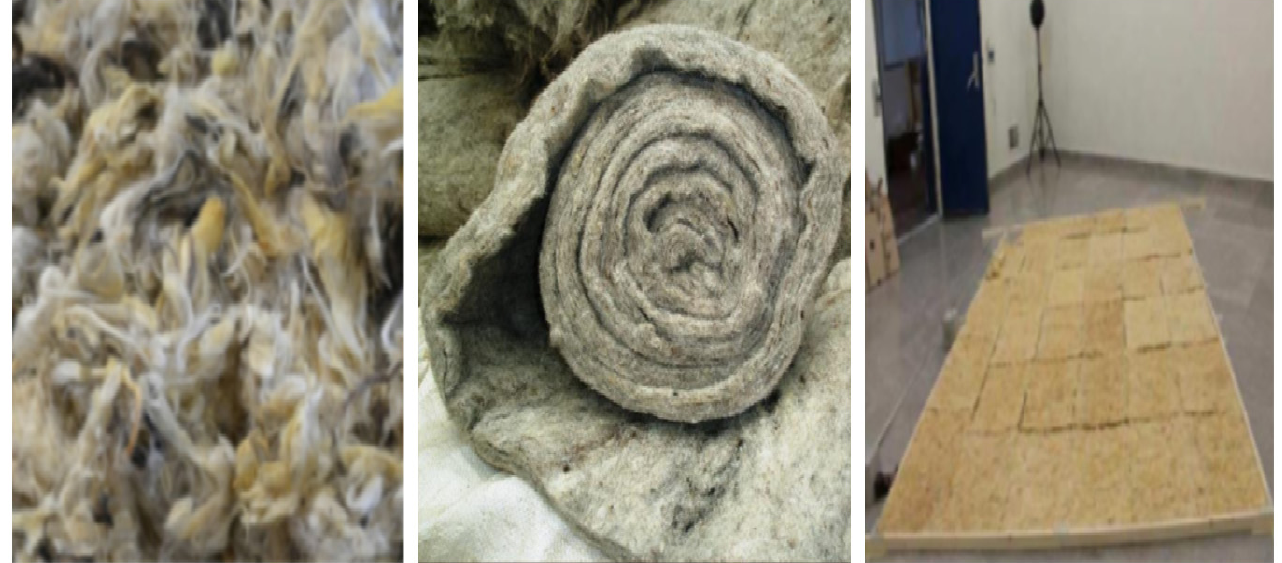
Figure 5. Applications of sheep wool insulation in building constructions [1,23].